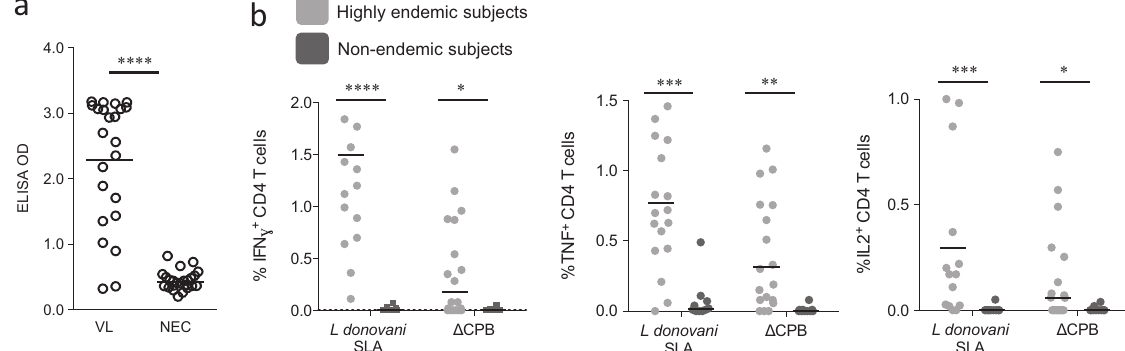
Fig. 1 Recognition of truncated cysteine protease B protein ( Δ CPB) by L. donovani- affected individuals. In a , serum antibodies against Δ CPB were measured by ELISA in samples from VL patients ( VL ; n = 23) and non-endemic control individuals ( NEC ; n = 24). Each point represents the response of each individual sample with black bars indicating the mean OD for each group. In b , peripheral blood mononuclear cells from subjects living in either a highly endemic ( n = 20) or non-endemic ( n = 10) region were incubated with L. donovani SLA or Δ CPB prior to analyses by fl ow cytometry to identify CD4 T cells producing IFN- γ , TNF or IL-2, respectively. Each point represents the response of each individual sample with black bars indicating the mean for each group. Positive responses were determined as having optical densities ( OD ) or cell populations greater than the mean plus 3 s.e.m of that observed with NEC. Statistical signi fi cance was calculated by Kolmogorov – Smirnov test, * p < 0.05, *** p < 0.001, and **** p < 0.0001